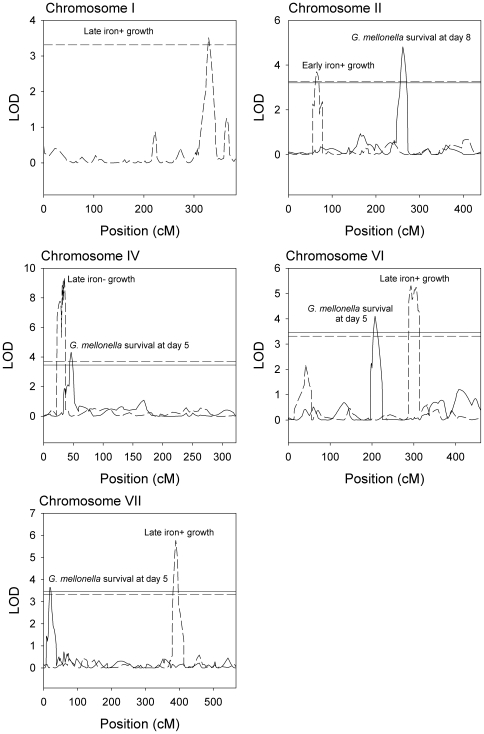
LOD plots from composite interval mapping of growth and virulence for Chromosomes I, II, IV, VI, and VII.Horizontal lines show the genome-wide significance thresholds obtained by permutation. For LOD plots and thresholds, dashed lines denote growth traits and solid lines denote virulence traits. For clarity, we have omitted plots for early and late iron-supplemented growth and early iron-limited growth on Chromosome IV and plots for early iron-supplemented growth on Chromosome VI.